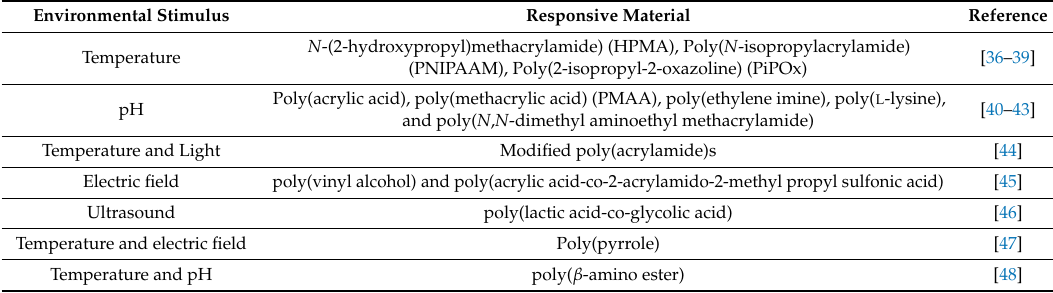
Table 1. Various stimuli and responsive materials.